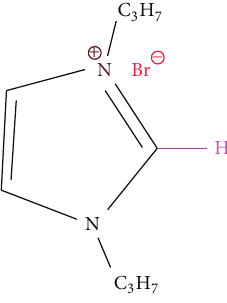
Figure 1: Structure of the 1,3-dipropylimidazolium bromide ionic liquid (IL) [(1,3-Pr 2